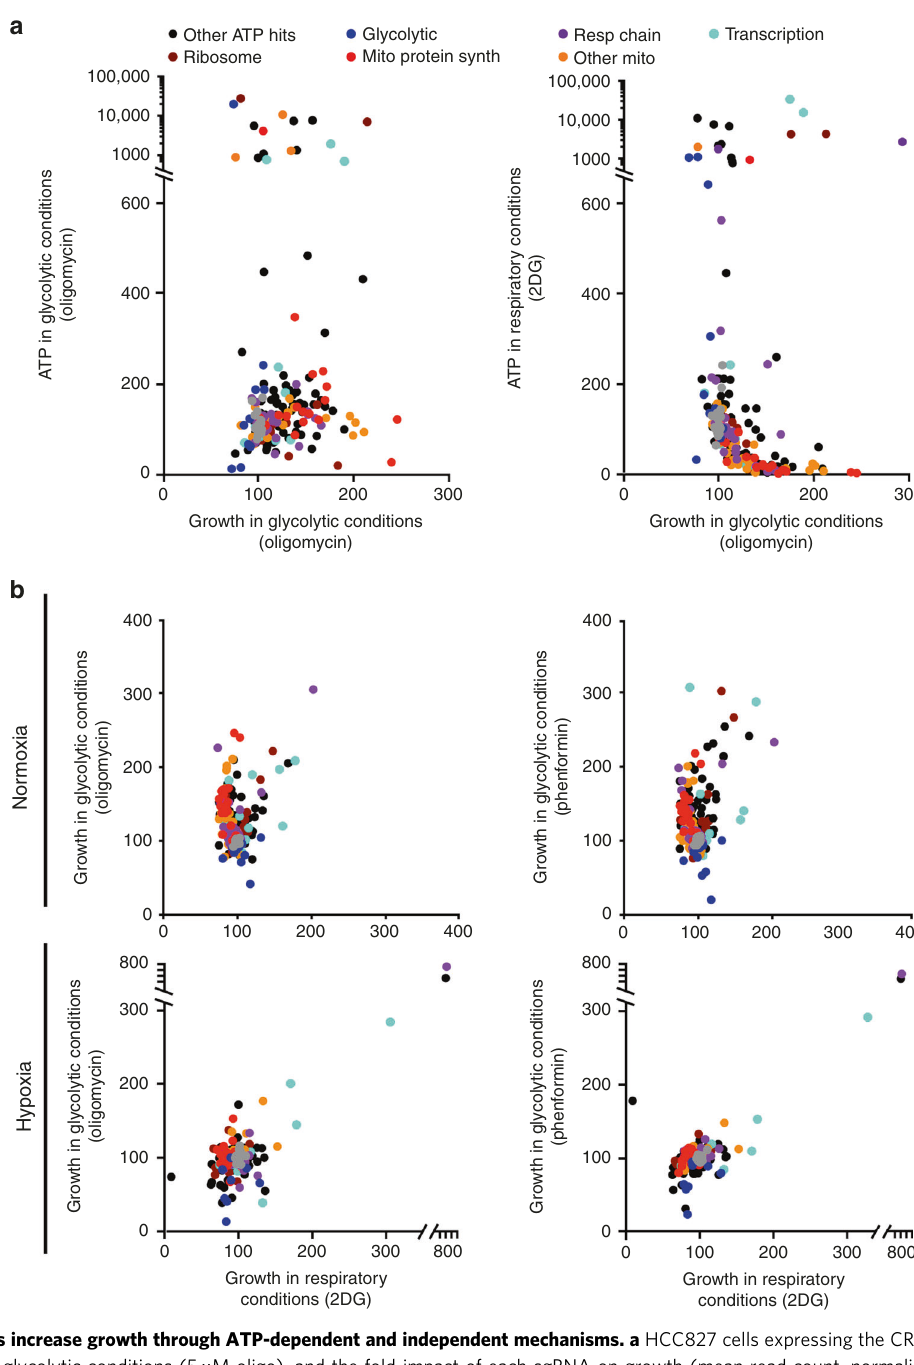
Fig. 6 High ATP hits increase growth through ATP-dependent and independent mechanisms. a HCC827 cells expressing the CRISPRi mini-library were grown for 3 days in glycolytic conditions (5 μ M oligo), and the fold-impact of each sgRNA on growth (mean read count, normalized to nontargeting controls) plotted versus ATP level measured in parallel experiments. Data from four replicates of 1 M collected cells per group for ATP, six replicates of 1 M collected cells per group for growth. For growth and ATP in glycolytic conditions, nontargeting guides Pearson r = − 0.162, n = 19, p = 0.510; all targeting guides r = 0.361, n = 185, p < 0.001; glycolytic r = 0.796, n = 9, p < 0.05; mitochondrial ribosome r = 0.600, n = 14, p = 0.0234, p -values for nonzero slope or null hypothesis of no correlation by Pearson ’ s correlation test after removing outliers with ROUT method. b HCC827 cells expressing the CRISPRi mini- library were grown for 3 days in either glycolytic (5 μ M oligo or 0.5 mM phenformin) or respiratory (10 mM 2DG) substrates, both in normoxia (top) and hypoxia (1% O 2 , bottom), and the impact of metabolic substrate on growth compared. In normoxia, knockdown of 48/77 and 40/78 mitochondrial genes increased growth >3 SD from nontargeting guides in oligo and phenformin, respectively, while only 3/78 did for either substrate in hypoxia. n = 3 replicates of 1 M collected cells per group for growth in hypoxia, and n = 6 replicates of 1 M collected cells per group for growth in normoxia. Source data, exact p -values, and 95% con fi dence intervals are provided as a Source data fi